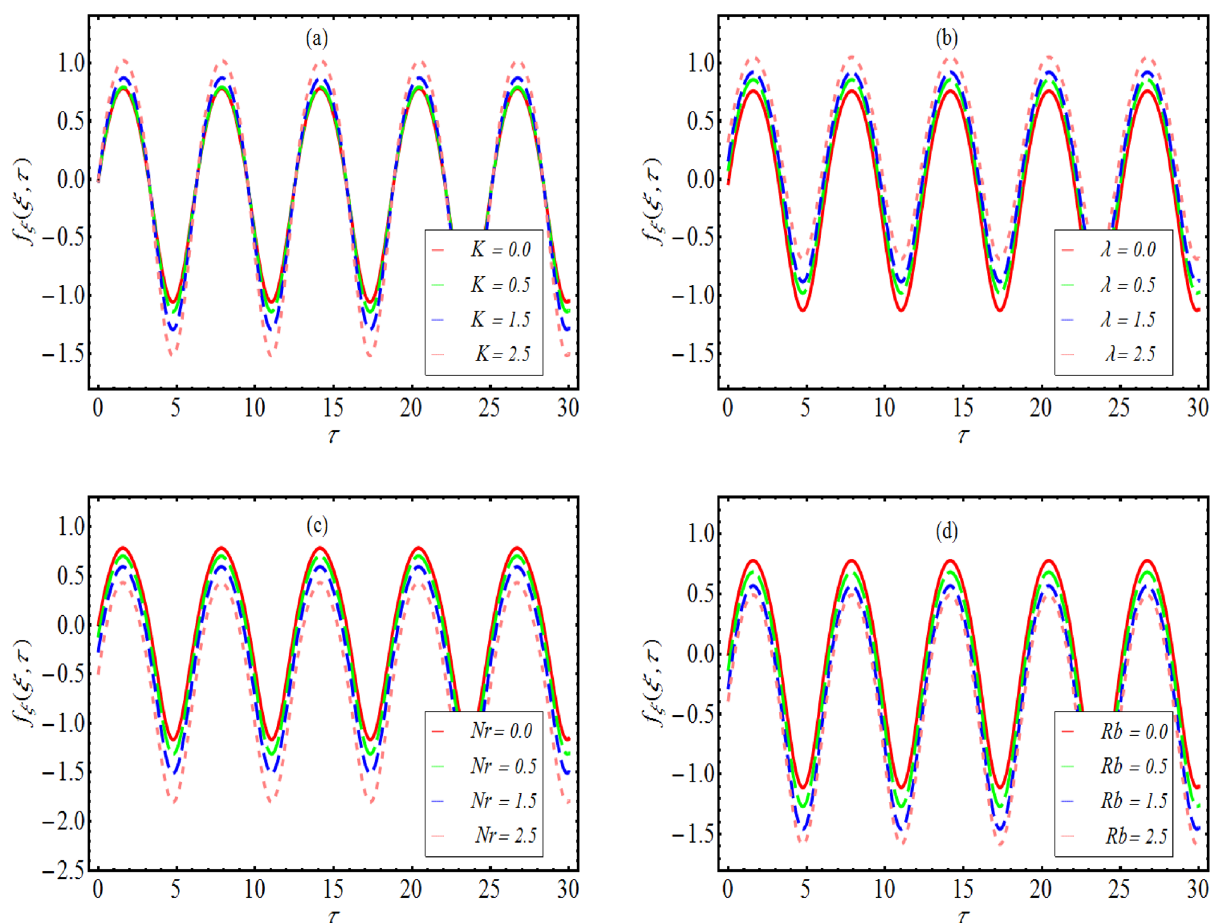
Figure 3. Variation of f ξ with τ for various values of ( a ) K ( b ) (cid:31) ( c ) Nr and ( d ) Rb